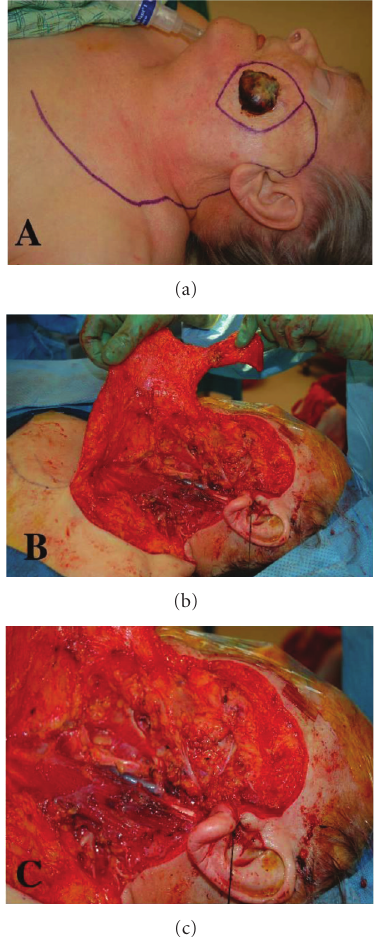
Figure 1: Macroscopic appearance of Merkel cell carcinoma. (a) Surgical photo showing red, violaceous, and firm nodule with a smooth, elevated surface. Markings depict large cervicofacial rotation flap to reconstruct the expected defect. (b) Surgical photo depicting superficial parotidectomy and level I–IV lymph node dissection. (c) Close-up picture of b.